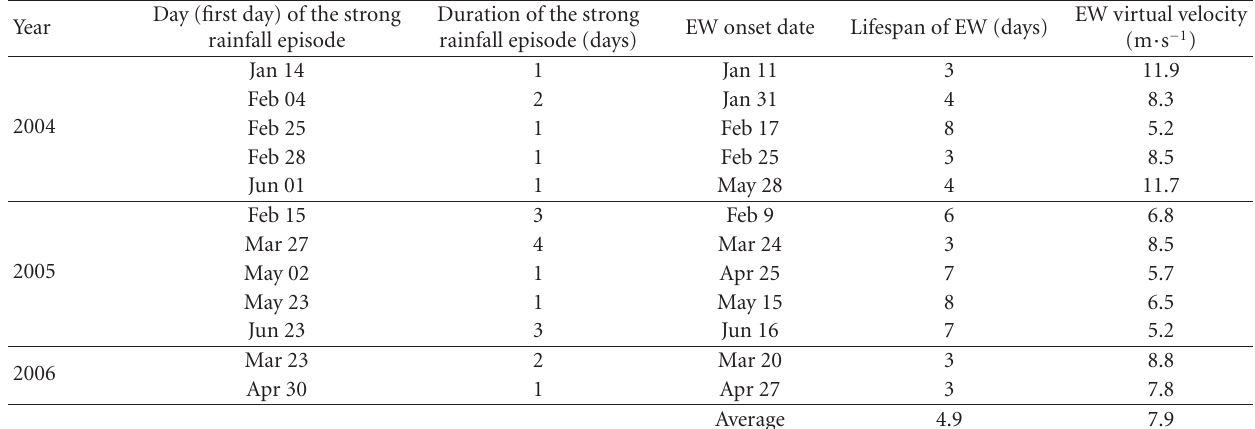
Table 1: Characteristics of the twelve selected events observed in 2004, 2005, and 2006. The day (or first day) of strong rainfall episode over ENEB, duration (days) of strong rainfall episode, EW onset date, lifespan (days) of EW, EW virtual velocity (m · s − 1 ) are given for each